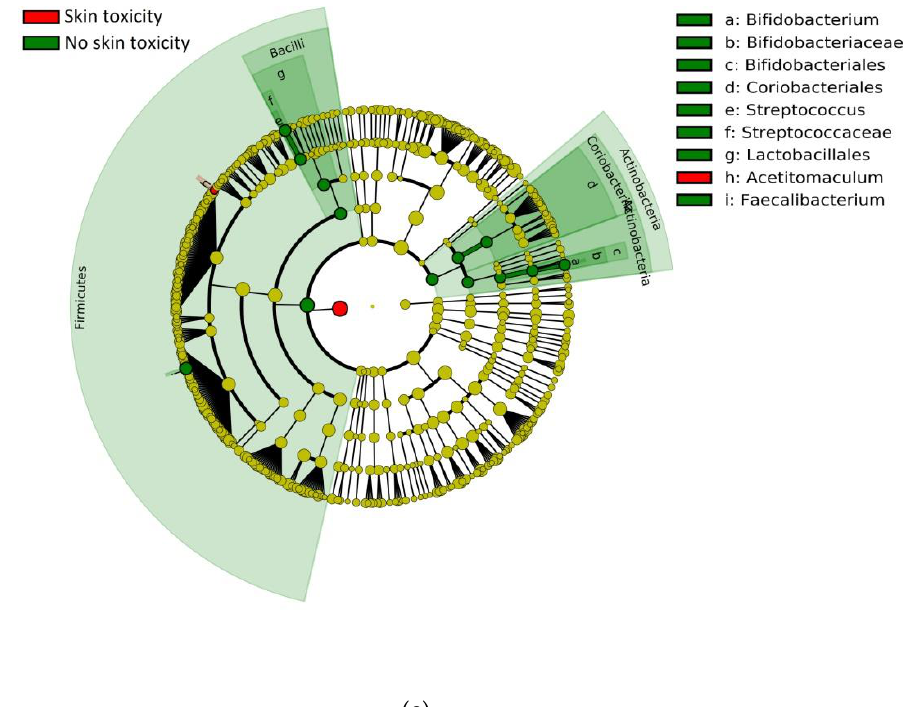
Figure 3. Gut microbiota composition and ICB-related skin toxicity. ( a ) Chao 1, ( b ) Shannon, and ( c ) inverse Simpson indices scores of the gut microbiota in patients stratified according to the presence/absence of skin toxicity by Mann–Whitney U rank sum test. Error bars represent the distribution of alpha-diversity scores. ( d ) Multi-level differential abundance analysis using linear discriminant analysis (LDA) effect size (LEfSe) in patients stratified according to skin toxicity. ( e ) Taxonomic cladogram stratified by skin toxicity. Dot size is proportional to the abundance of the taxon. Green legends represent the patients without skin toxicity, and red legends represent the patients with skin toxicity associated with ICB treatment. LDA score > 3.0; p < 0.05.